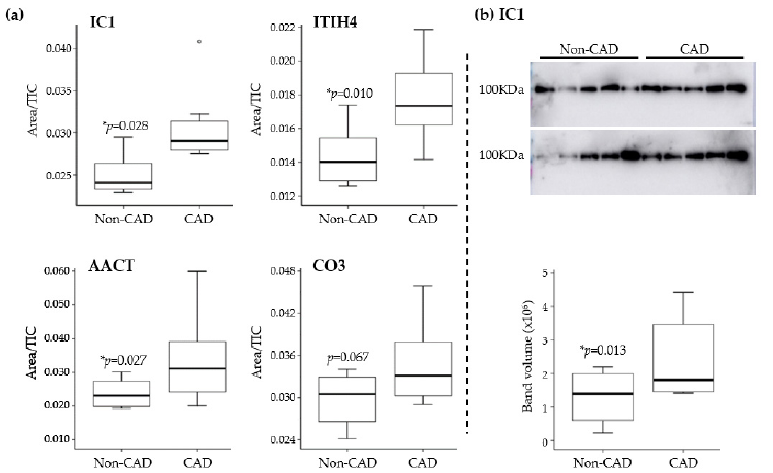
Figure 3. Results from plasma analysis in the verification phase. ( a ) Parallel reaction monitoringanalysis allow the measuring of plasma protease C1 inhibitor(IC1), inter-alpha-trypsin inhibitor heavy chain H4 (ITIH4), alpha-1-antichymotrypsin(AACT) and complement C3 (CO3), showing higher levels of protein in patients with coronary artery disease (CAD) in all cases. ( b ) Western blot of IC1, which confirmed the increased levels observed in parallel reaction monitoringanalyses. TIC, total ion